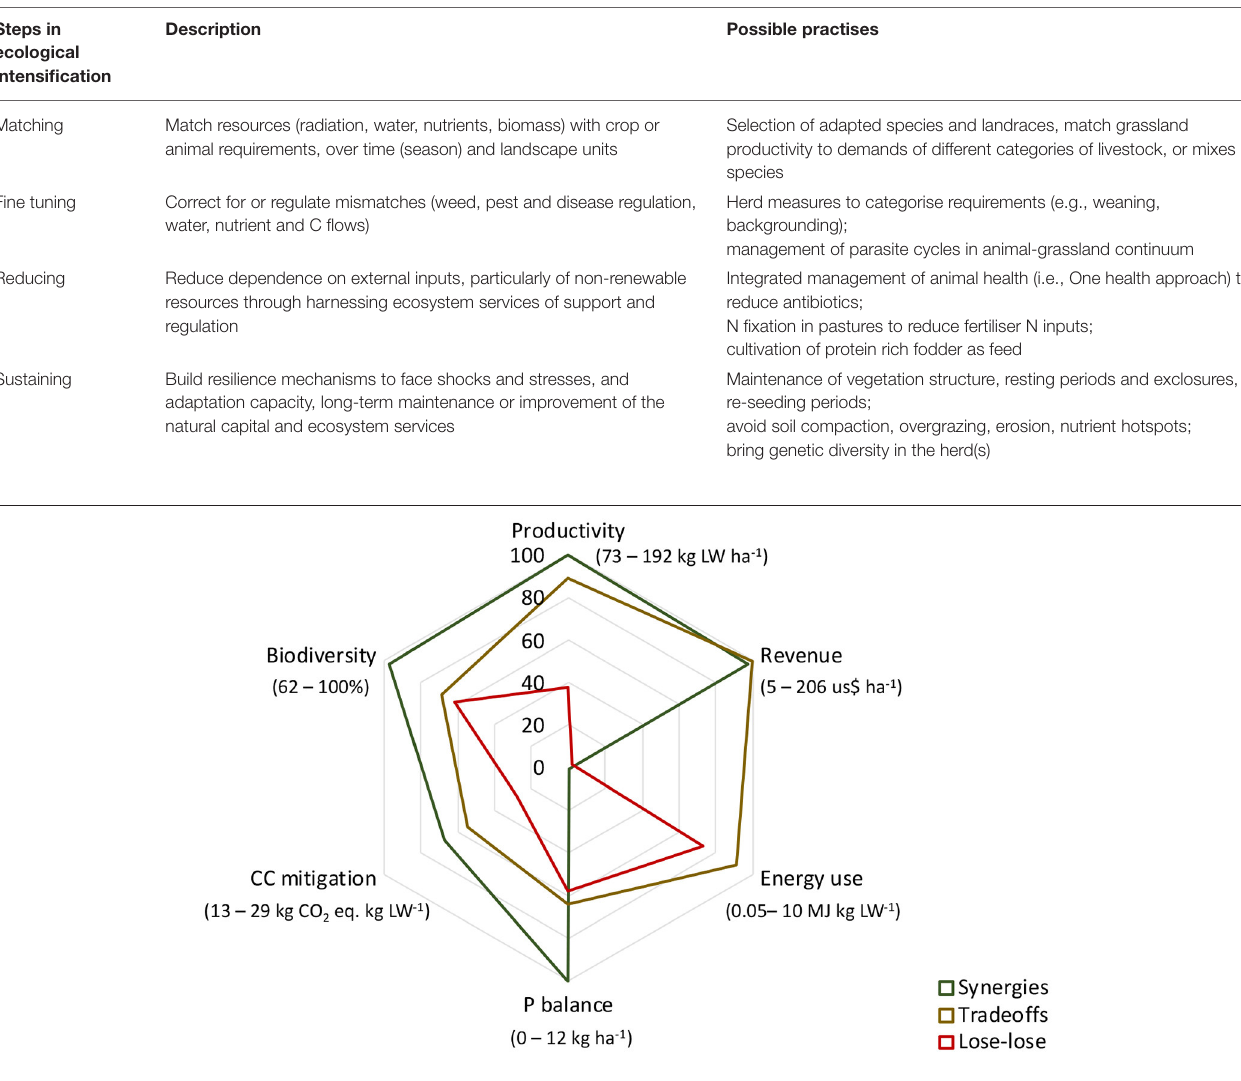
FIGURE 3 | Economic and environmental performance of archetypal grazed-based livestock farms in Uruguay, Rio de la Plata Grassland Biome, derived from a survey of 280 cases by Modernel et al. (2018). The archetype analysis was based on a Pareto ranking of the sampled farms with respect to the various indicators (plus N balances, not shown in this graph). Four archetypes were found that represented win-win (synergies), win-lose (trade-offs), lose-win, and lose-lose situations in terms of these economic and environmental indicators, using local expert knowledge for benchmarking. Lose-win situations are not represented in this graph, as viable economic performances are a non-negotiable requisite to local stakeholders. Only 41 farms fitted these four archetypes of which only five farms stood out as win-win cases. Values between brackets indicate the range of average values for each archetype (min-max). Graphics built with data presented by Modernel et al.